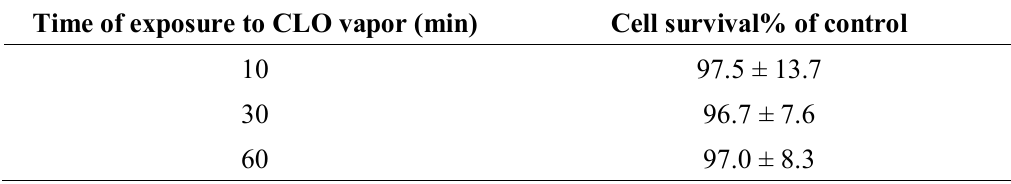
Table 3. Viability of cells exposed to CLO